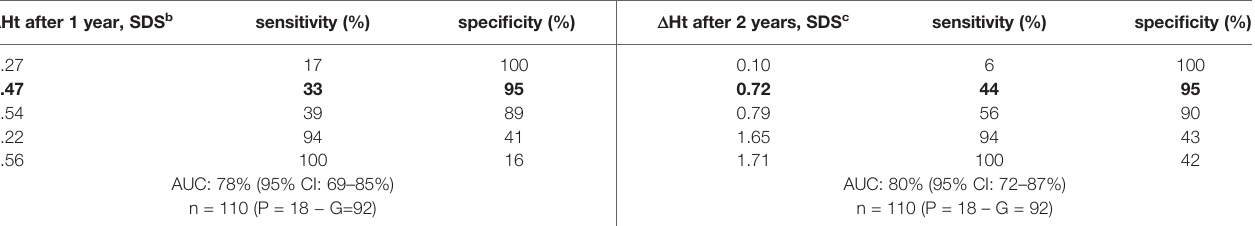
TABLE 4A | ROC curve analysis: cut-off values for D Ht SDS after 1 and 2 years of prepubertal GH treatment, with its sensitivity and speci fi city to predict total D Ht SDS <1 (A21). D Ht after 1 year, SDS b